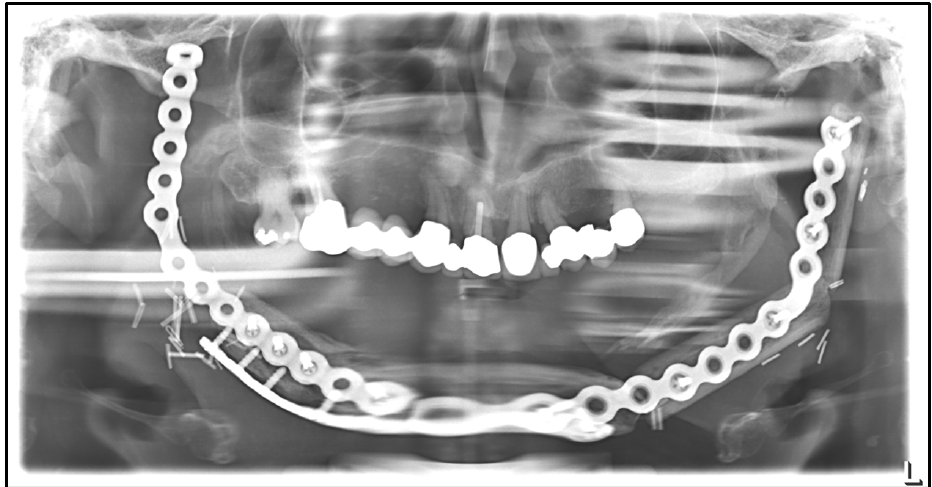
Figure 10. Dental X-ray after total mandibular resection and reconstruction with a fibular free flap. Fractured hand-bent plate in the right anterior region and supporting reconstruction plate on the basal rim of the neo-mandible.